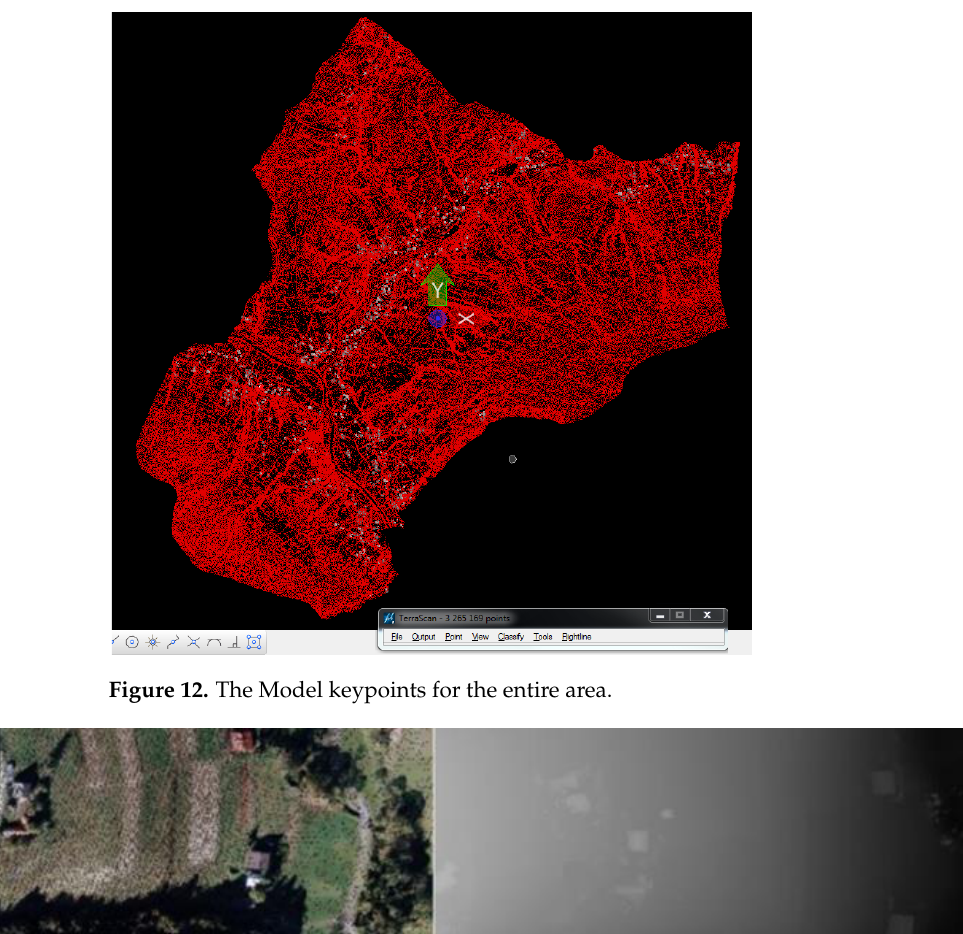
Figure 13. The cloud of points from the fragment of Kamionka Wielka (on the left ), along with the corresponding digital surface model ( right ).